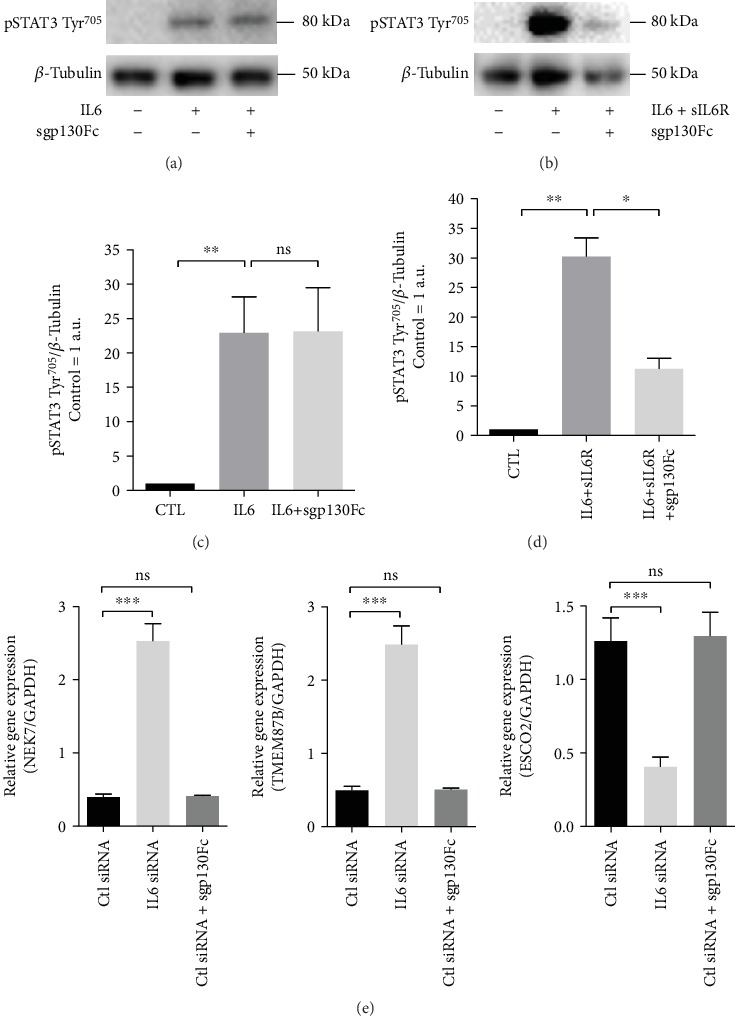
Specific blockage of IL6-transsignaling does not affect genes differentially regulated after IL6 knockdown in human endothelial cells. Soluble gp130 Fc fusion protein (sgp130Fc) was used to evaluate whether specific blockage of IL6 transsignaling affects the gene expression of 3 selected genes differentially regulated after IL6 knockdown. sgp130Fc does not affect the phosphorylation of STAT3 induced by IL6 classic signaling (a, c) but inhibits phosphorylation of STAT3 induced by IL6 transsignaling (IL6+sIL6R) (b, d). Gene expression of three genes differentially regulated after IL6 knockdown (NEK7, TEMEM87B, and ESCO2) was not affected by sgp130Fc (e). Data from 3 to 4 independent experiments are shown. Phosphorylation of STAT3 was evaluated after 30 min treatments and gene expression after 48 h. IL6 was used at a concentration of 50 ng/ml, sIL6R at 10 ng/ml, and sgp130Fc at 1 μg/ml. ∗p < 0.05, ∗∗p < 0.01, and ∗∗∗p < 0.001.